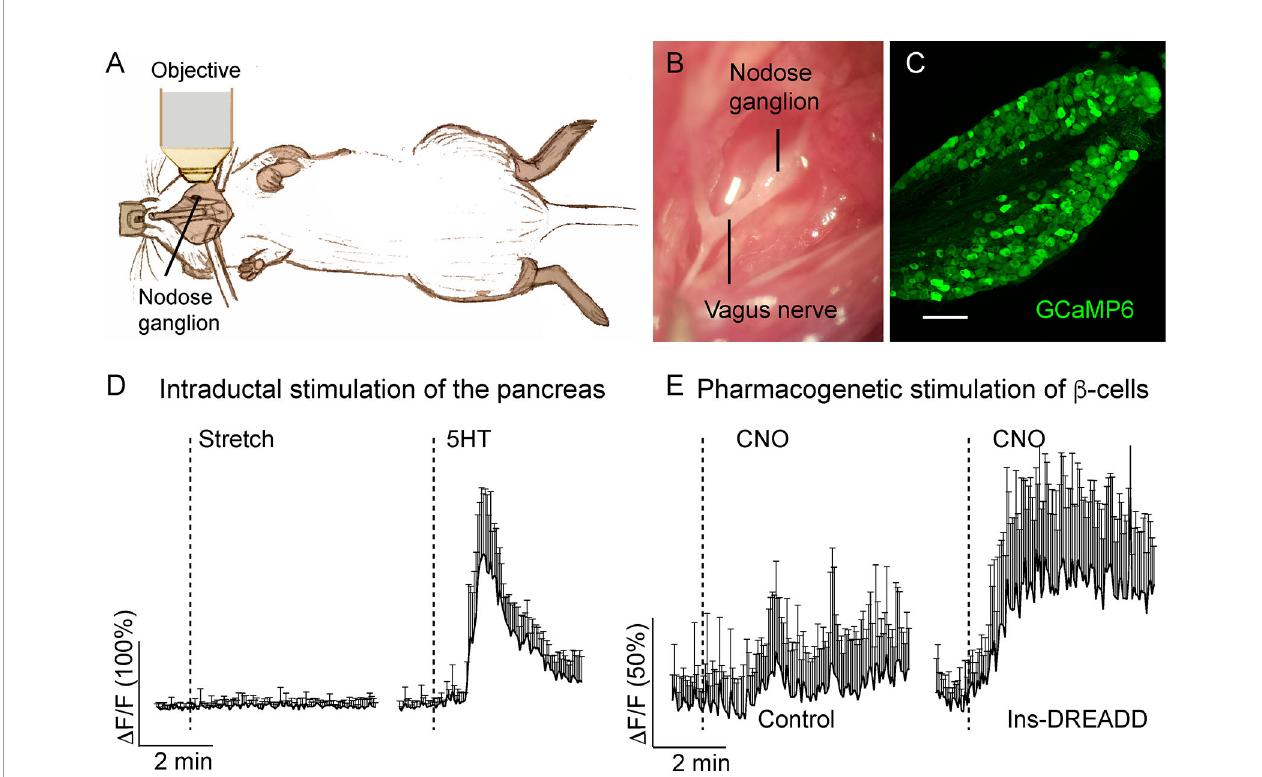
FIGURE 6 | In vivo imaging of the mouse nodose ganglion ( fi gure adapted and modi fi ed from Figures 3, 4 in Makhmutova et al, 2020). (A) Drawing illustrates the experimental set up, where the intact nodose ganglion is exposed for Ca 2+ imaging under a confocal microscope. (B) Photomicrograph of the exposed nodose ganglion. (C) Section of the nodose ganglion from a Pirt-GCaMP6 mouse. (D) Average traces of fl uorescence intensity changes over baseline ( d F/F) in nodose ganglion neurons, demonstrating neuronal responses to stretch (intraductal pancreatic infusion with saline, 300 µl/min) or intraductal application of 5-HT (1 mM, 150 µl/min). (E) Average traces of fl uorescence intensity changes over baseline ( d F/F) in nodose ganglion neurons, demonstrating neuronal responses to pharmacogenetic stimulation of b -cells by i.p. injection of clozapine nitric oxide (CNO, 5 mg/kg) in control mice or in mice expressing designer receptor activated by designer drug (DREADD) exclusively in b -cells. Shown is the mean trace of 10 neurons (+/-